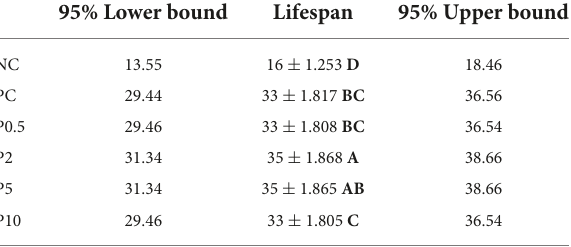
TABLE 2 Longevity (median ± SE days) and 95% confidence interval (median days) in caged honey bees fed with different